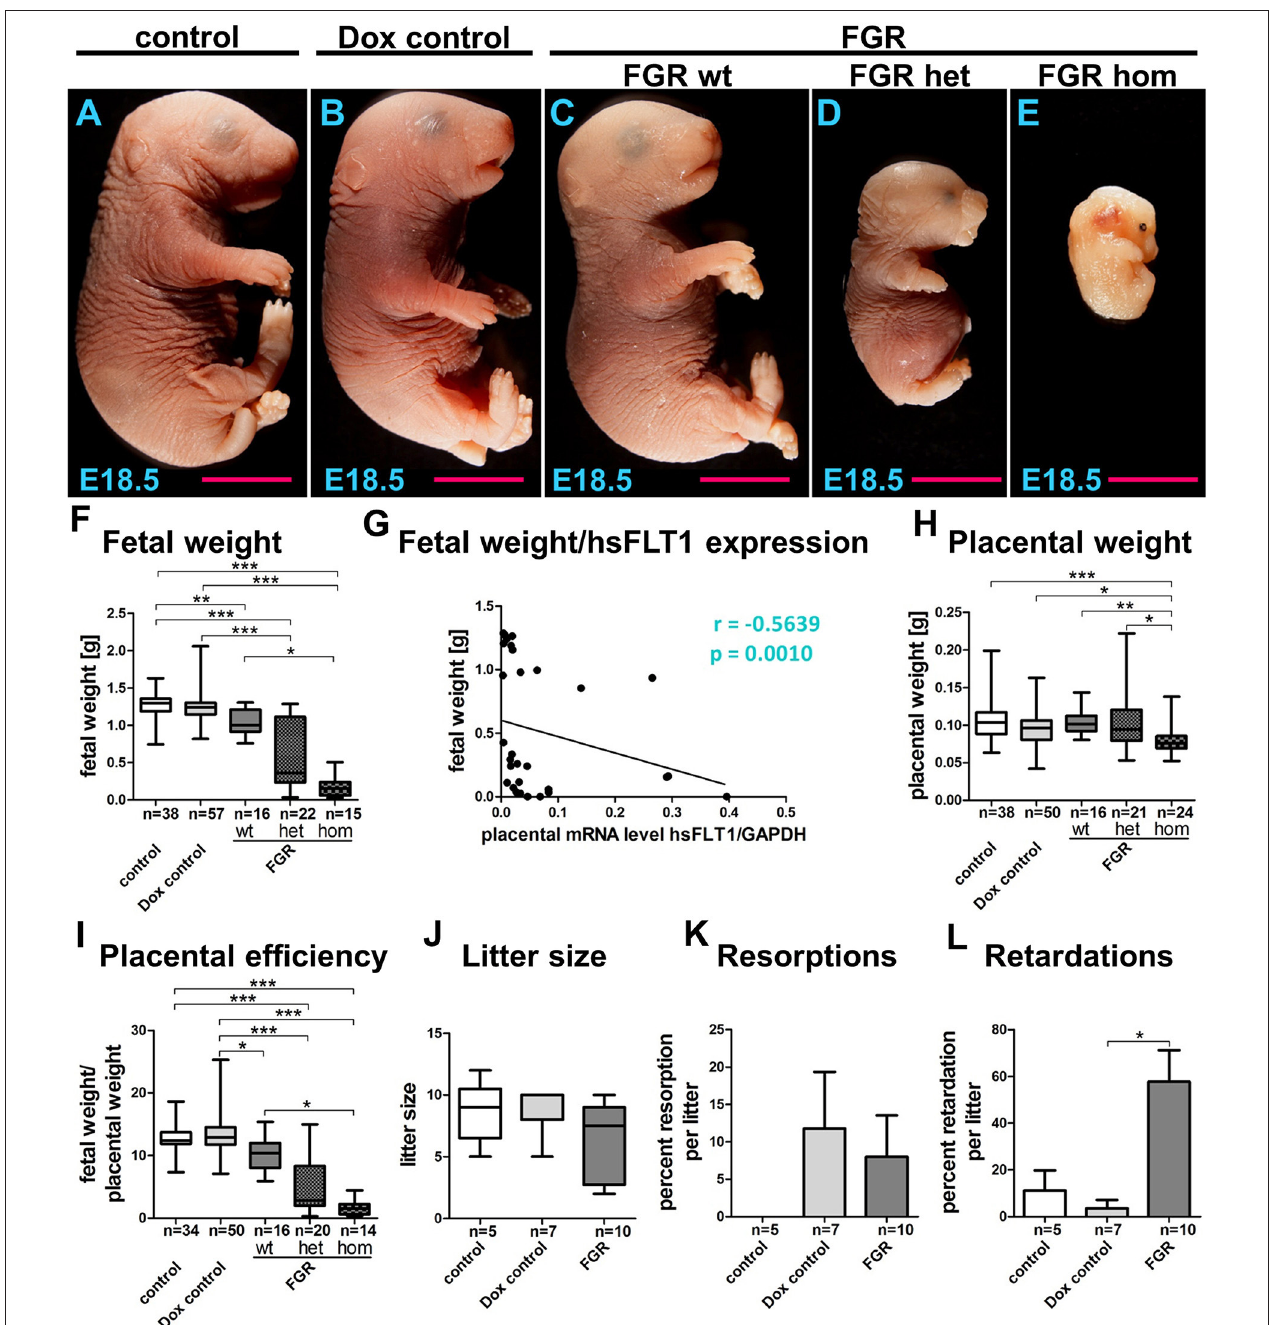
FIGURE 3 | Phenotype of the hsFLT1/rtTA mouse model. Analysis of fetal outcome (fetal weight, litter size, resorptions, and retardations) and the placental phenotype (placental weight, placental efficiency) at day 18.5 post coitum. (A–E) Consequences of ubiquitous maternal and/or fetal overexpression of human soluble fms-like tyrosine kinase 1 (hsFLT1) in fetal growth restriction (FGR) homozygous (hom), FGR heterozygous (het), or FGR wild-type (wt) fetuses, showing strong (A) , medium (B) , or mild (C) effects on fetal size in contrast to the control group, which did express hsFLT1 (D) . Treating the dam with doxycycline (Dox) (single hsFLT1 mice) produced no negative effects on fetal size (E) . These observations were confirmed by analysis of fetal weights (F) and by the correlation of fetal weight to placental hsFLT1 expression (G) . Placental weight was decreased only in the FGR hom group upon the highest expression of hsFLT1 in fetus and dam (H) , whereas placental efficiency (fetal weight/placental weight) is reduced in each FGR group in association with the corresponding hsFLT1 expression levels (I) . Litter size (J) and number of resorptions (K) did not vary between mouse cohorts; however, signs of retardation, such as cyanosis or demise of the fetus, increased in frequency upon hsFLT1 expression (L) . Data show hsFLT1/rtTA (FGR) or single hsFLT1 (Dox control) mice treated with Dox at early to midgestation and untreated controls. * p < 0.05, ** p < 0.01, *** p < 0.001 as determined by the Kruskal–Wallis test with Dunn’s post hoc test. Correlation analysis was performed with Spearman’s rank correlation coefficient.